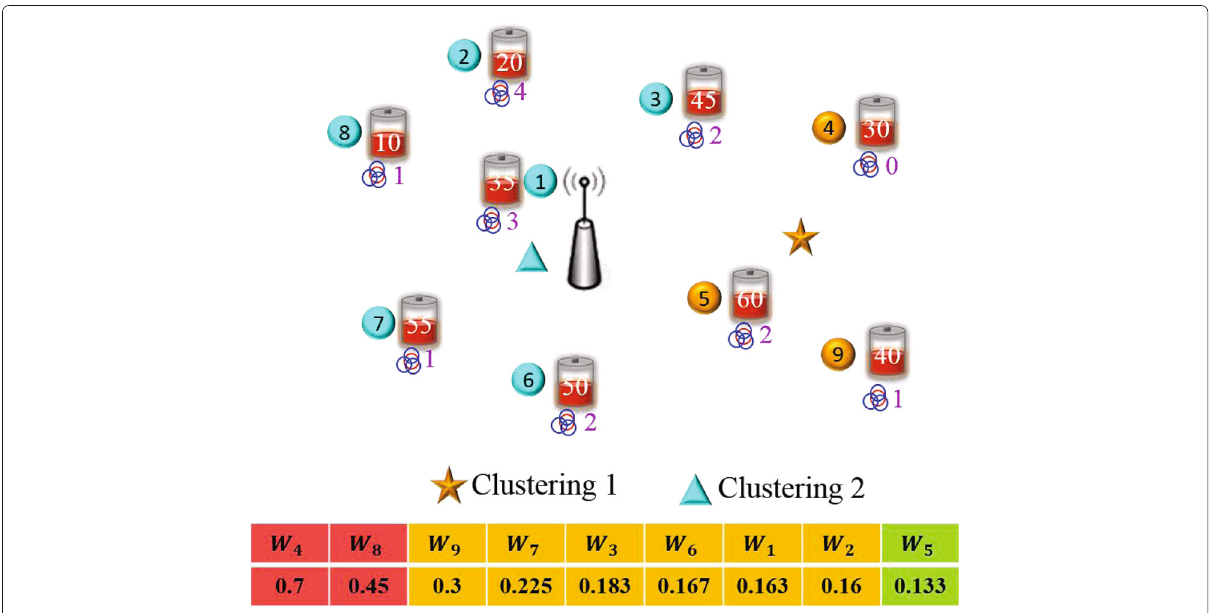
Fig. 10 The result after k-means clustering, where k = 2